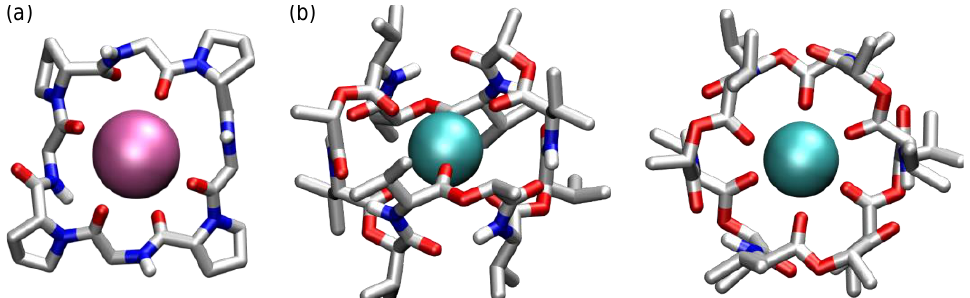
Figure 2. Crystal structure of the Rb + complex of 1b (CSD Entry: CPRGLR) ( a ), and side and top view of the crystal structure of the K + complex of 2 (CSD Entry: TEFBAH) ( b ). Solvent molecules, counterions, and protons, except acidic ones, are omitted for reasons of clarity.